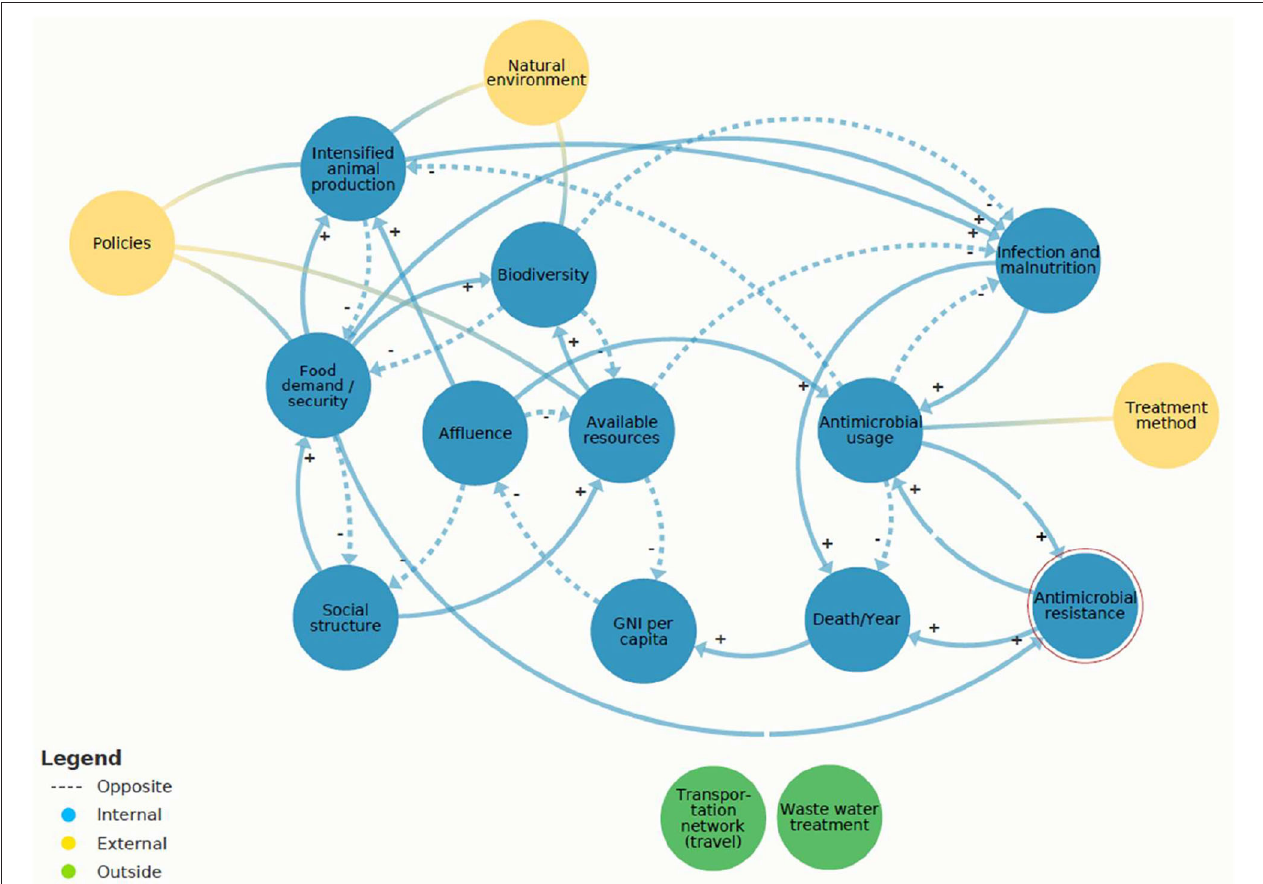
FIGURE 3 | Present antimicrobial resistance (AMR) system map created in Kumu.io (27) https://www.kumu.io/LeaMat20/amr-system-map#untitled-map. The internal system elements (blue) are connected with arrows indicating the negative (balancing) and the positive (reinforcing) feedback loops. These interconnections are based on the hard variables (i.e., physical flows) and soft variables (i.e., information flows). The breaks in the arrows, which are leading to “AMR,” indicate a time delay. The three yellow circles (i.e., policies, natural environment, and treatment method) depict the external elements that affect the internal objects. The two green elements (i.e., transportation network and wastewater treatment) symbolize systems outside of the system boundaries.